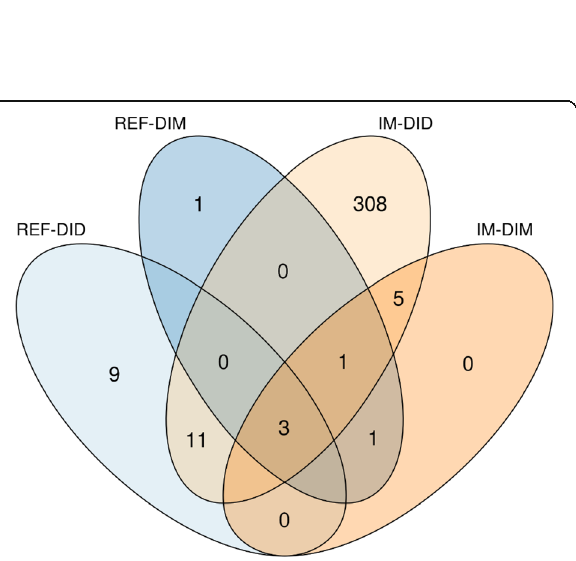
Fig. 2 Venn ’ s diagram showing the shared and unique core ASVs in each sample type. The core ASVs were computed using a prevalence threshold at 80%. REF, reference diet; IM, insect meal diet; DID, distal intestine digesta; DIM, distal intestine